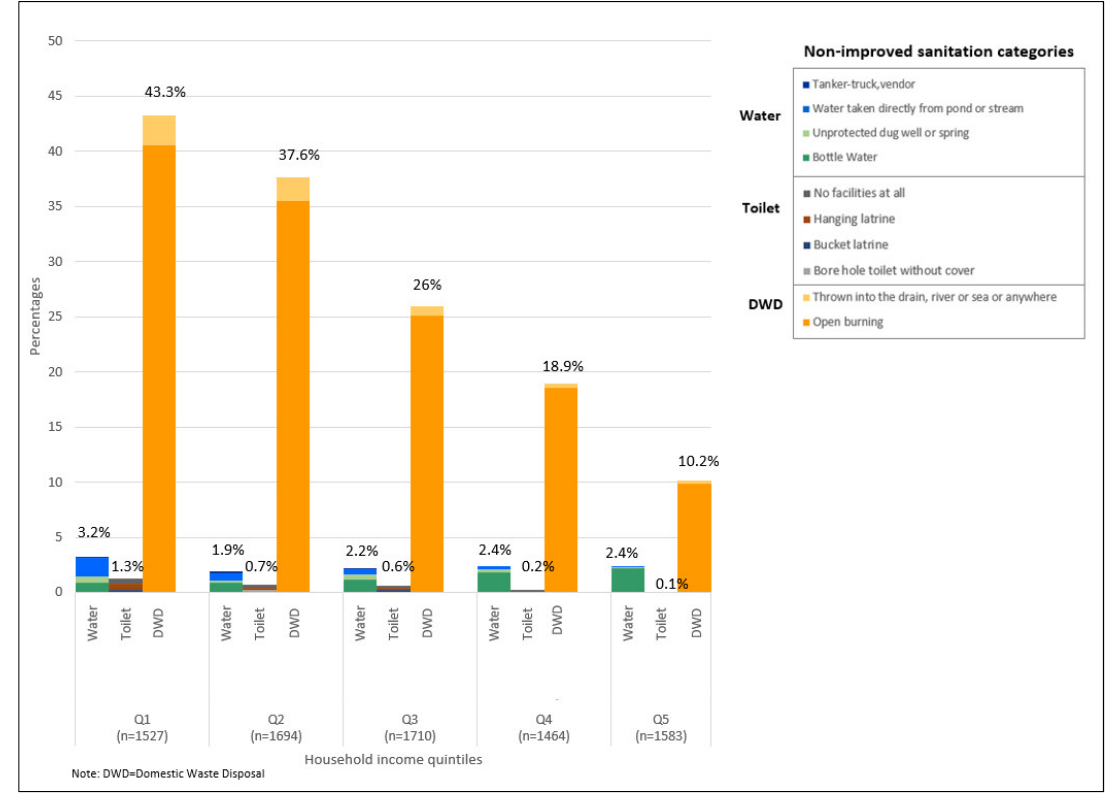
Figure 6. Non-improved sanitation categories by household income quintile.